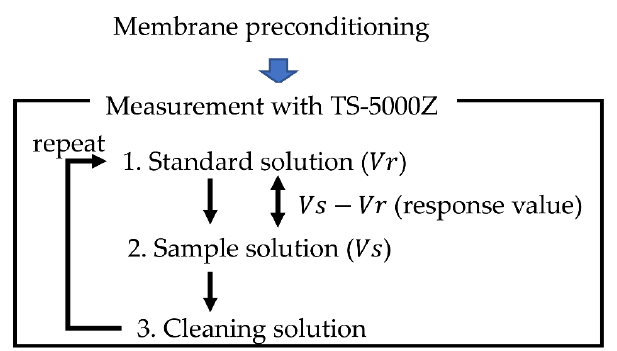
Figure 4. Measurement procedure of taste sensor.